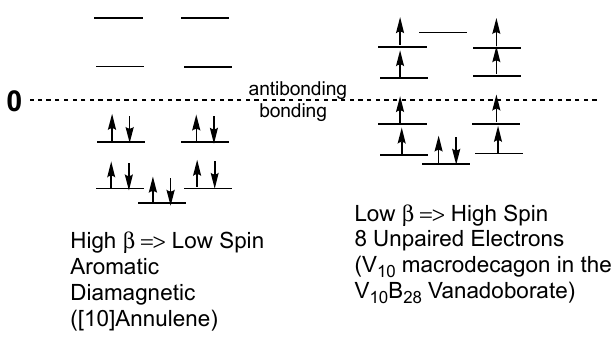
Figure 4. Comparison of the energy levels and spin states in [10]annulene and in the V 10 macrodecagon in the V 10 B 28 vanadoborates, such as [V 10 B 28 O 74 H 8 ] 16 − .